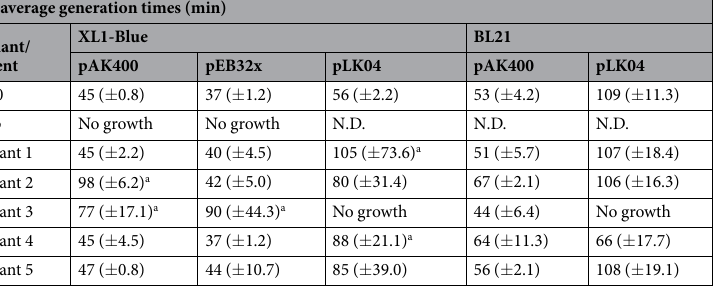
Table 1. The average generation times. The average generation times of the parent genes and the variants from three independent cultures are shown in the table. The standard deviations of the generation times are shown in parentheses. The variants that differ statistically significantly (Mann-Whitney U test) from Fab0 are marked by the letter “a”. “No growth” means that the parent or the variant could not be cloned or cultivated in liquid culture. N.D. = not